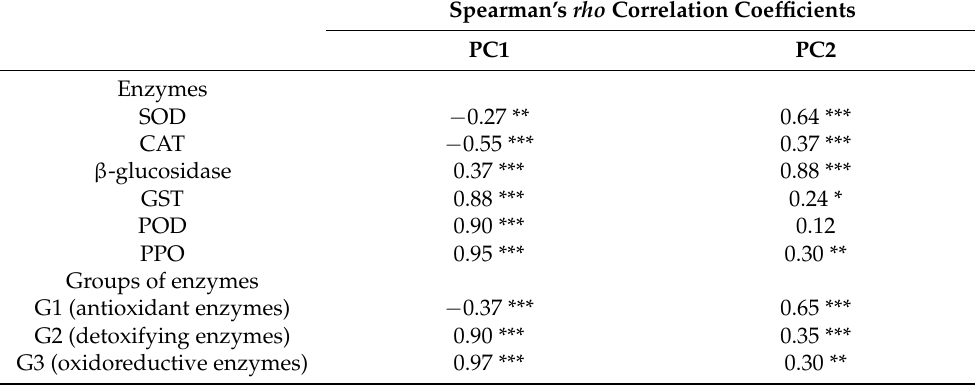
Table 3. Correlation between enzyme data from aphid species (individual enzymes and specific groups of enzymes) and PCA axes that represent changes in enzyme data depending on aphid developmental stage and temperature (Spearman rank correlation